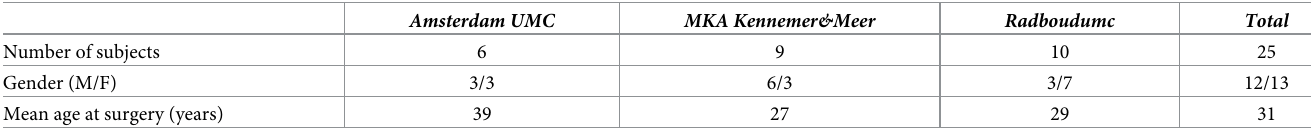
Table 2. Demographics of the